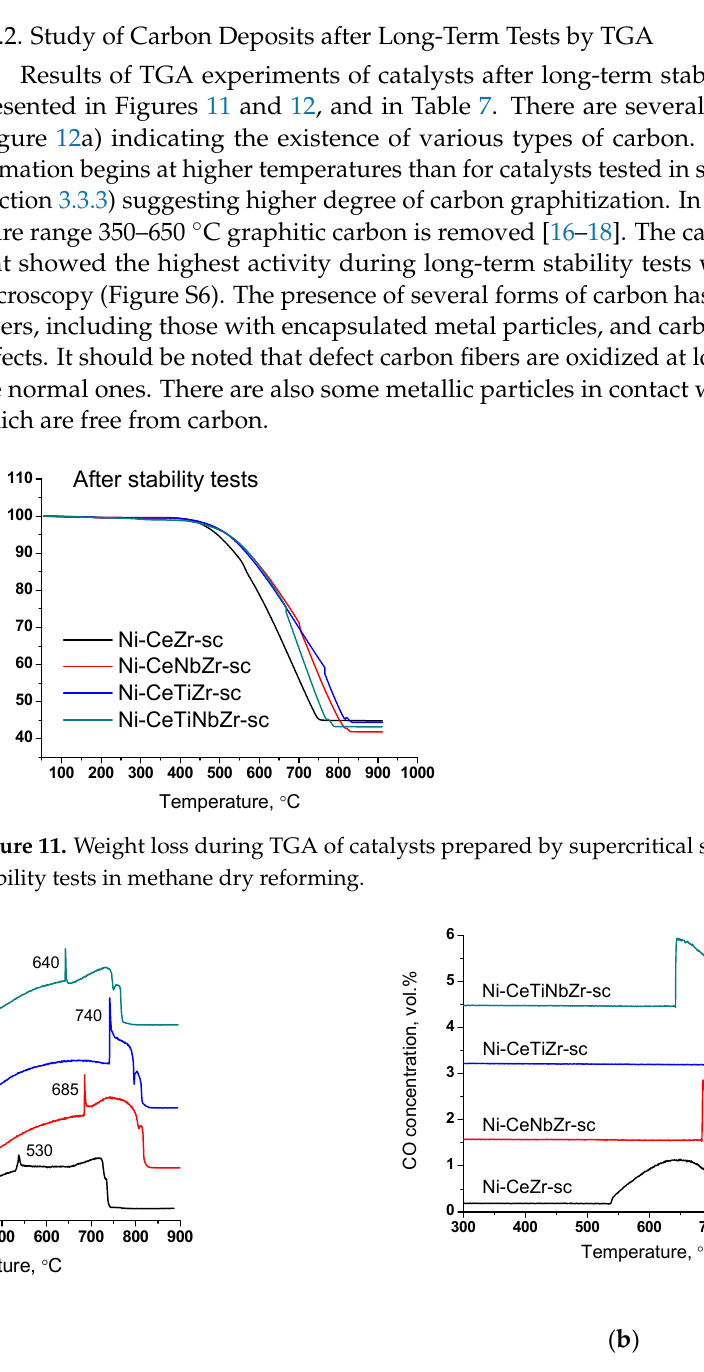
Figure 12. CO 2 ( a ) and CO ( b ) concentrations measured by mass-spectroscopy analysis during TGA of catalysts prepared by supercritical synthesis after long-term stability tests in methane dry reforming. At higher temperatures, a sharp increase in CO 2 concentration accompanied by CO appearance (Figure 12b) in products and a sharp mass drop on the TGA curve is